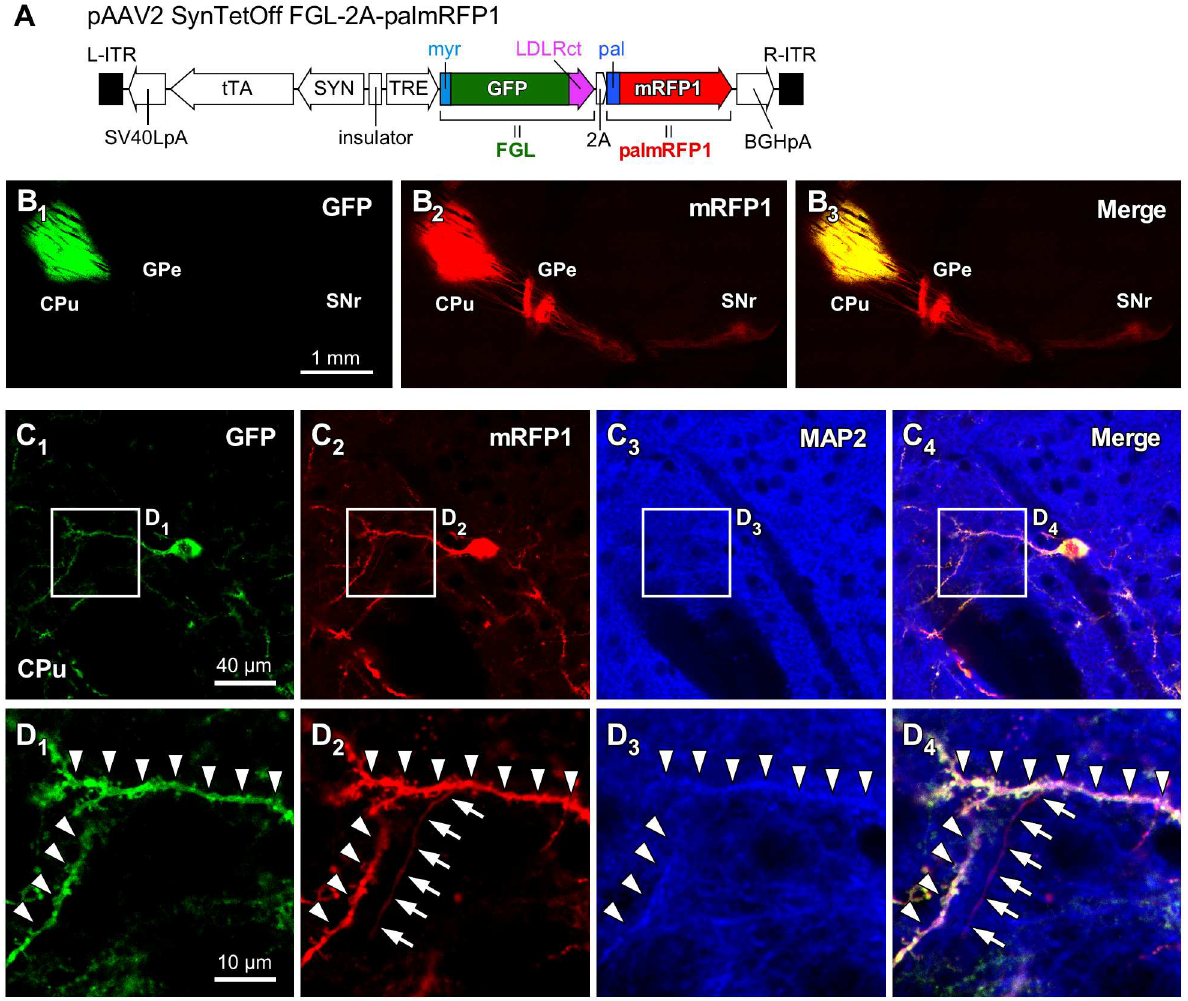
Fig 4. Dual-color labeling of the somatodendritic and axonal structuresof neostriatal neurons with the AAV-SynTetOff vectors. ( A ) Constructionof the vector plasmid, pAAV2-SynTetOff-FGL-2A-palmRFP1. ( B ) Sagittal view of brain sections with injectionof AAV2/ 1-SynTetOff-FGL-2A-palmRFP1 into the CPu. This AAV vector expressedboth FGL and palmRFP1 in the infected neurons. GFP-NF was restricted to the CPu, and mRFP1-NF was observednot only in the CPu but also the GPe and SNr, where neostriatalneuronsproject. ( C ) After immunofluorescence staining for MAP2 (blue), the sections were observedunder a confocallaser scanningmicroscope in the CPu. ( D ) High-magnification images in (C). Arrowheads and arrows indicate the dendriticand axonal structures, respectively.Scale bar in B 1 appliesto B 1 –B 3 . Scale bar in C 1 appliesto C 2 –C 4 . Scale bar in D 1 appliesto D 2 –E 4